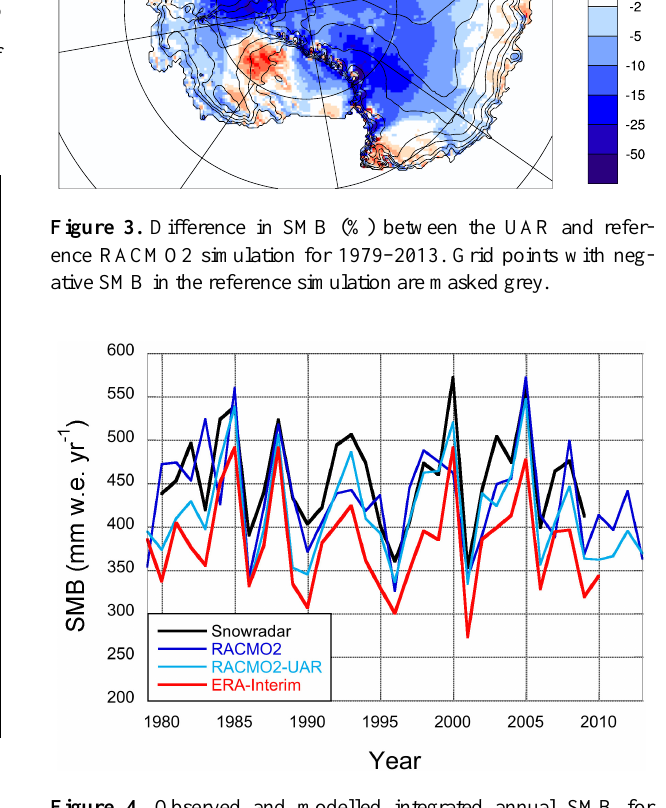
Figure 4. Observed and modelled integrated annual SMB for Thwaites Glacier catchment, West Antarctica (Fig.